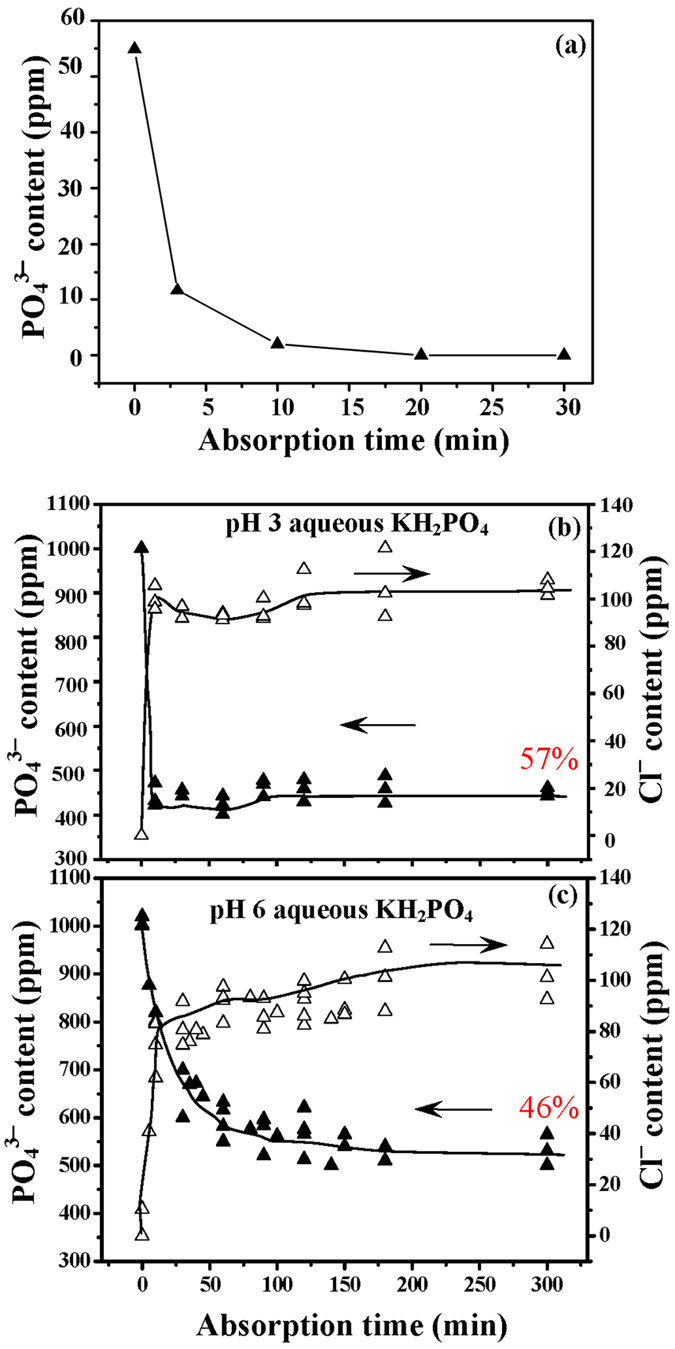
(a) PO43− sorption by
0.2 g Mg–Fe–Cl HTln in
100 ml aqueous KH2PO4 (original
55 ppm of PO43−);
(b,c) PO43− sorption
and Cl− desorption when immersing
0.2 g Mg–Fe–Cl HTln in
100 ml aqueous KH2PO4 (original
1000 ppm of PO43−), where
(b) sorption and desorption experiments being conducted at pH 3,
(c) sorption and desorption experiments being conducted at pH 6.
The pH values of the solutions were maintained by dropwises of
HNO3(aq).